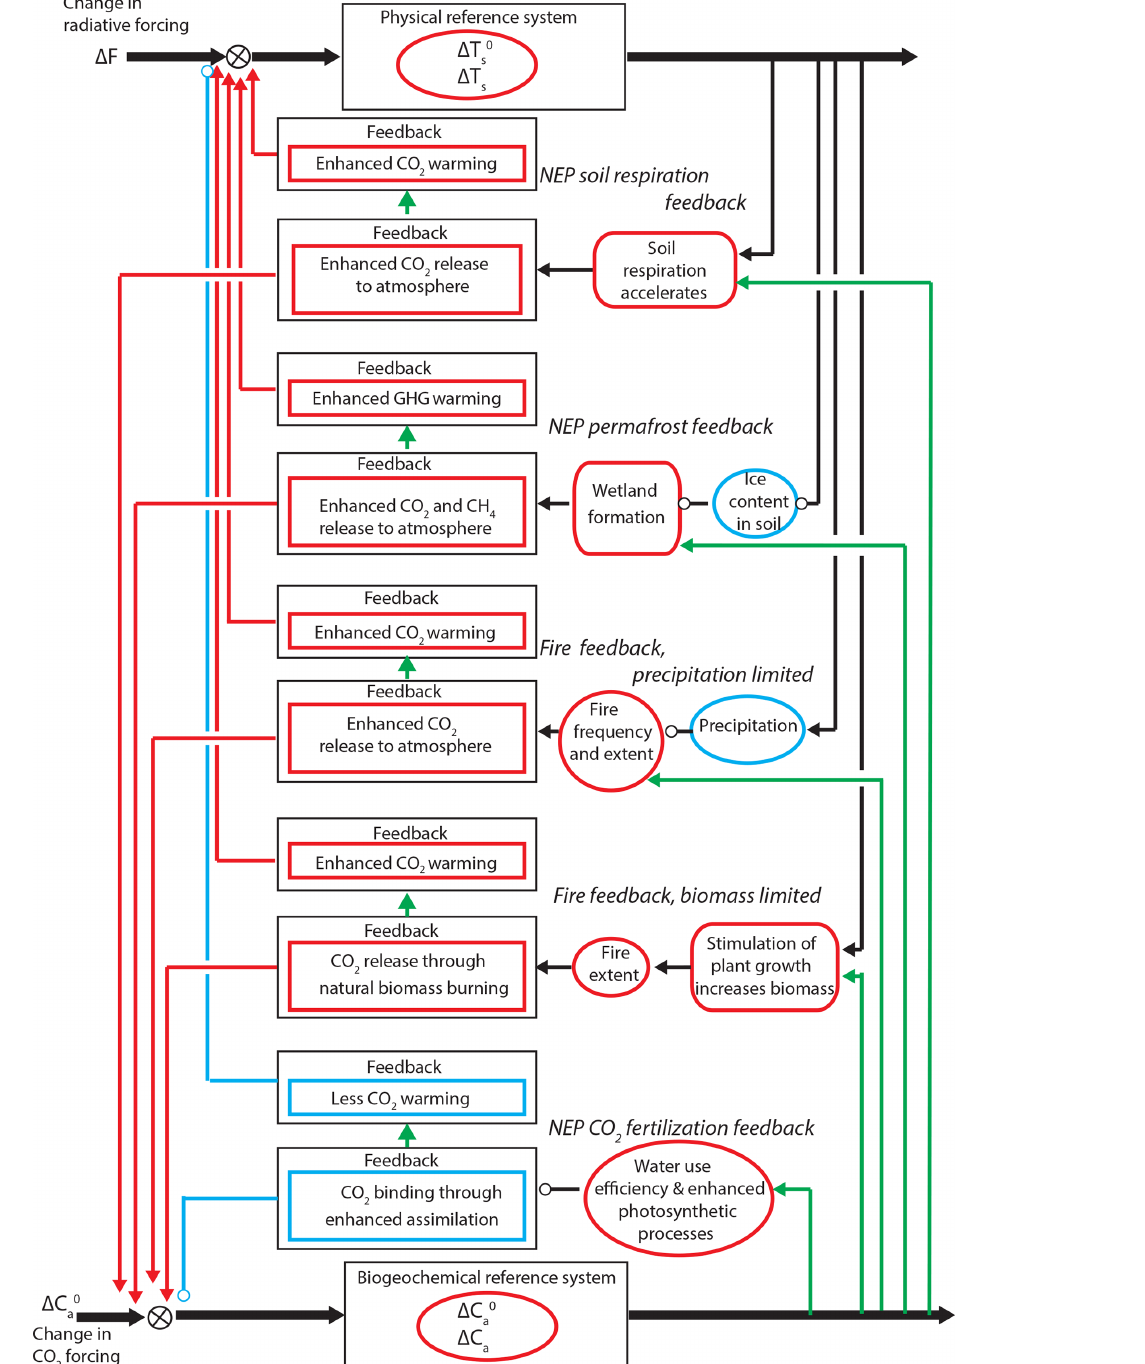
Figure 12. Schematic of important land biogeochemistry feedbacks. The fire feedback depends on the local change in precipitation or available biomass for burning. Arrows indicate positive coupling; open circles indicate negative coupling. Changes in state variables are indicated by ellipses, changes in processes by rounded rectangles. Red indicates increasing values of variables, strengthening of processes, or positive feedbacks; blue indicates the opposite. Green arrows and lines indicate couplings of biogeochemical processes to physical processes. The change in surface air temperature (cid:49)T s in the presence of feedback is different from the change (cid:49)T 0 s without feedback. The change in greenhouse gas concentration (cid:49)C a in the presence of biogeochemical feedback is different from that without this feedback ( (cid:49)C 0 a ).